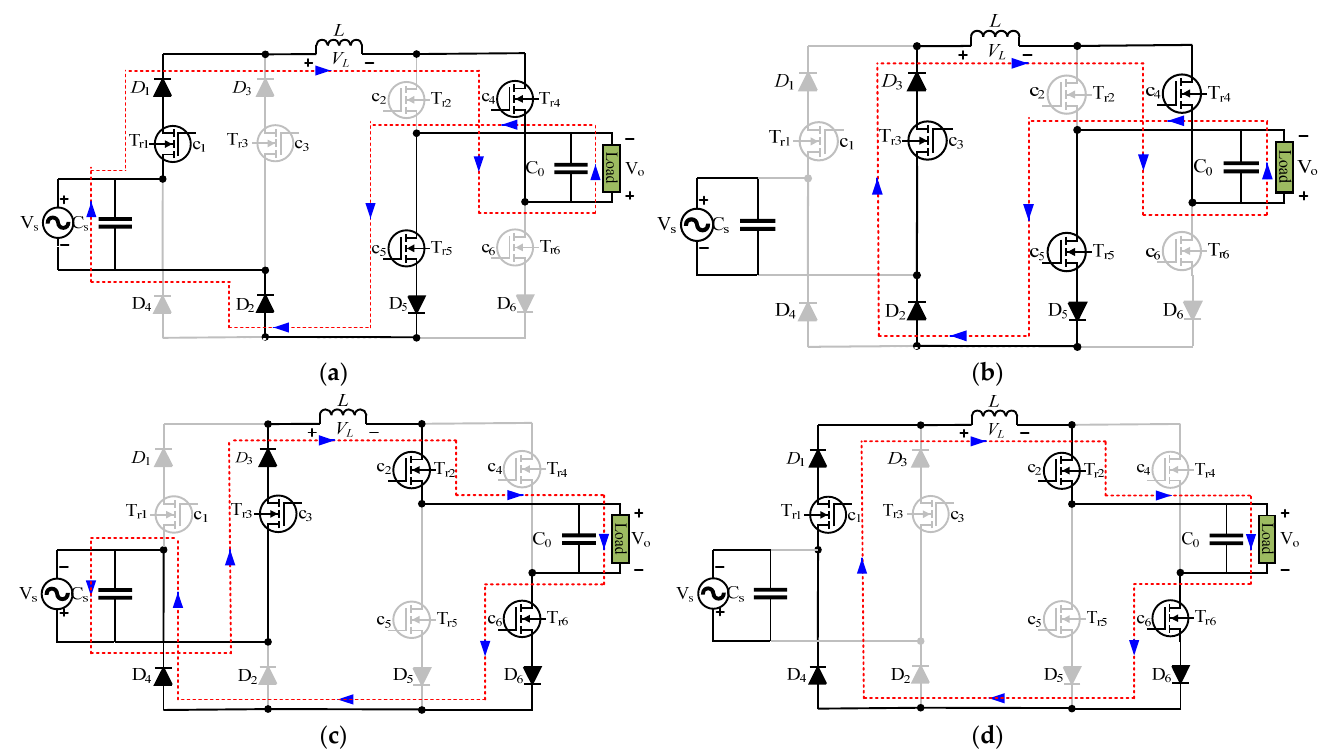
Figure 6. Equivalent power transfer loops formed by PWM control to have inverted voltage buck output for half cycles of ( a ) and ( b ) positive source voltage; ( c ) and ( d ) negative source voltage.